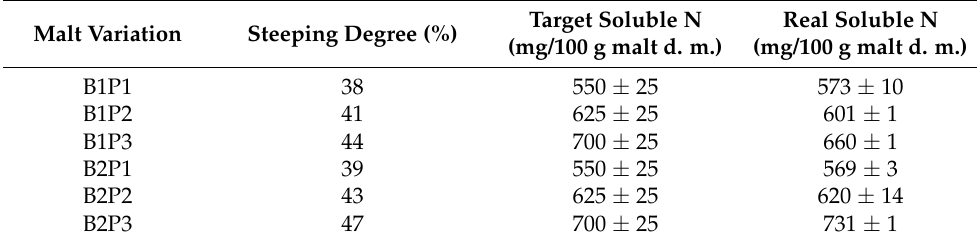
Table 1. Malt variation of the sample set: steeping degree, soluble N (target and real) [1]. Malt Variation Steeping Degree